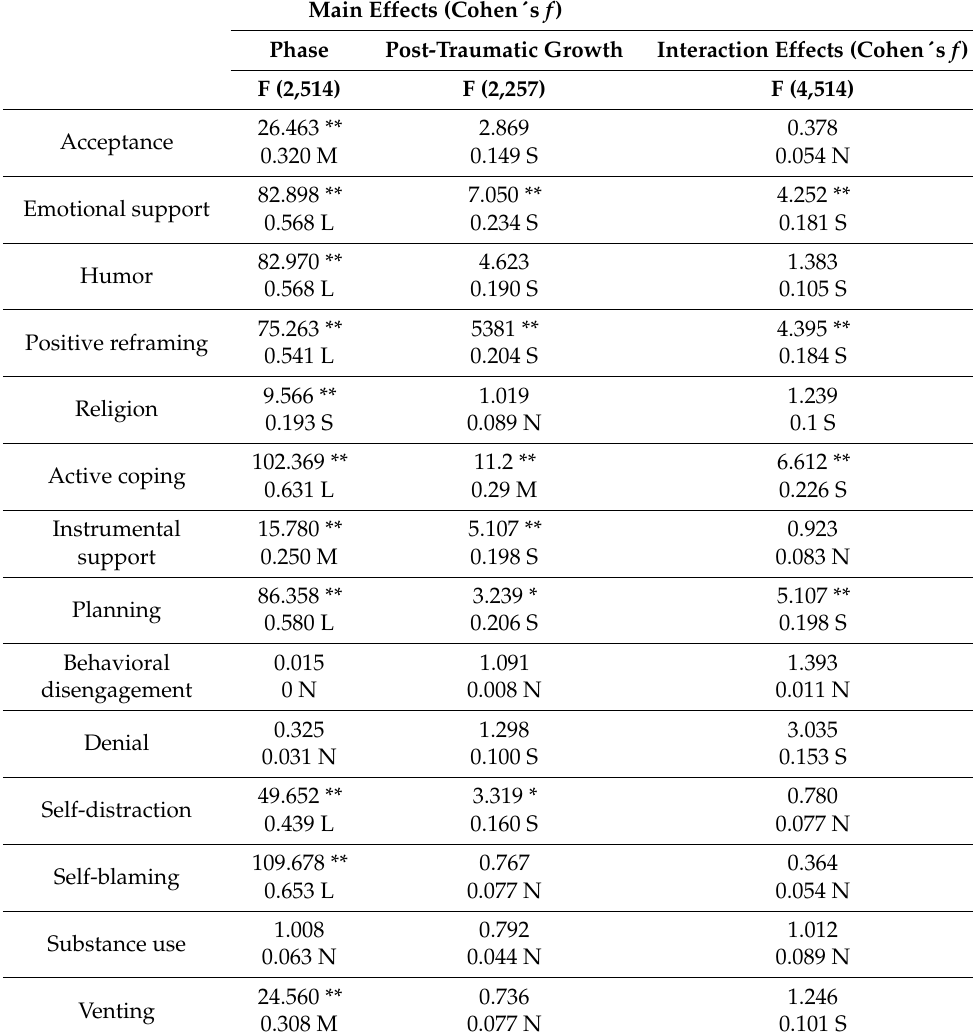
Table note: L = large effect size, M = medium effect size, S = small effect size, N = null effect size. Significance value * p < 0.05, ** p <